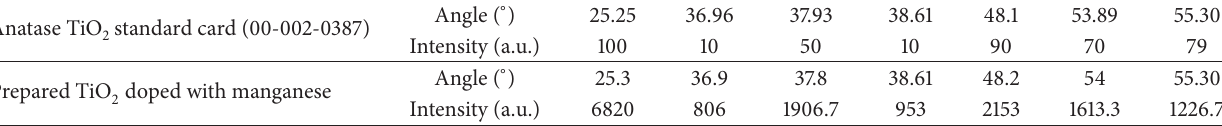
standard card and TiO 2